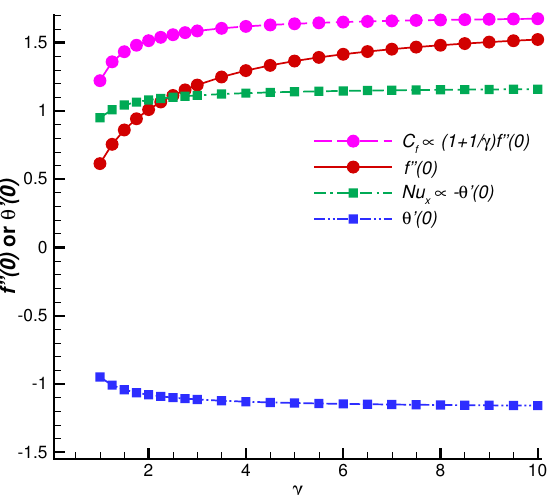
Figure 3. Comparison of convergent series solutions of f (cid:48)(cid:48) ( 0 ) ( C f ) and θ (cid:48) ( 0 ) ( Nu x ) obtained by HAM with the numerical results for different values of Casson fluid parameter γ when s = 2, M = 1, Pr = 0.71. Line: convergent series solutions; symbols: corresponding numerical